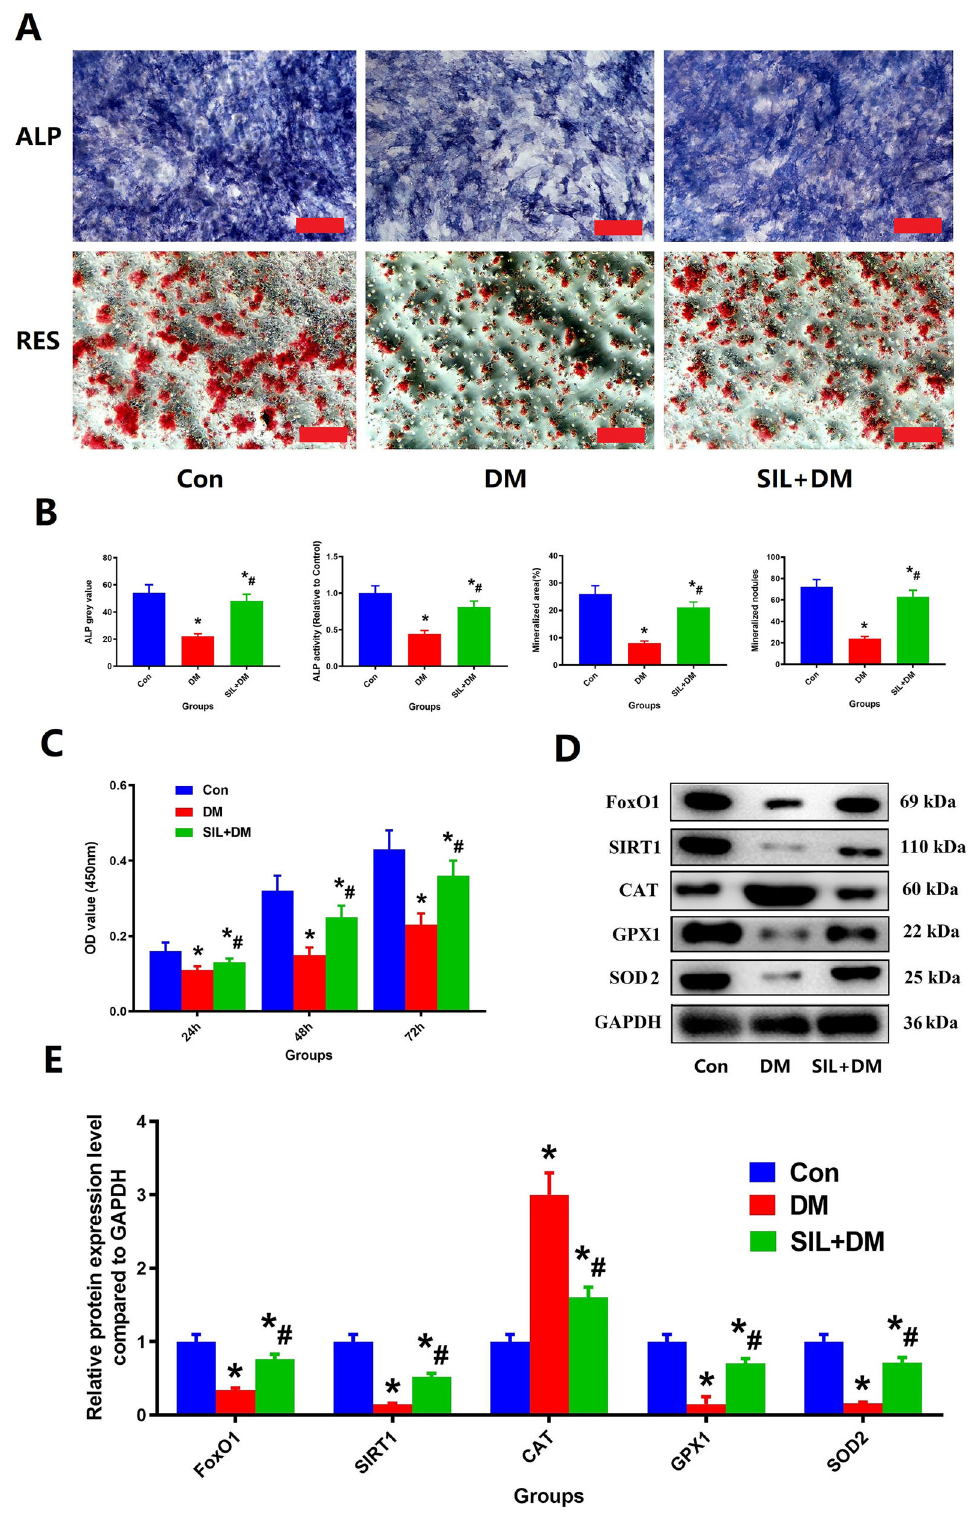
Fig. 2 SIL therapy could greatly enhance the biological activity of MC3TE-E1 in a hyperglycemia environment. A Representative pic- tures of ALP staining and RES staining of MC3TE-E1 under different intervention conditions; B : The quanti fi cation of mineralized nodules, mineralized area, ALP activity and ALP gray value; C : The results of